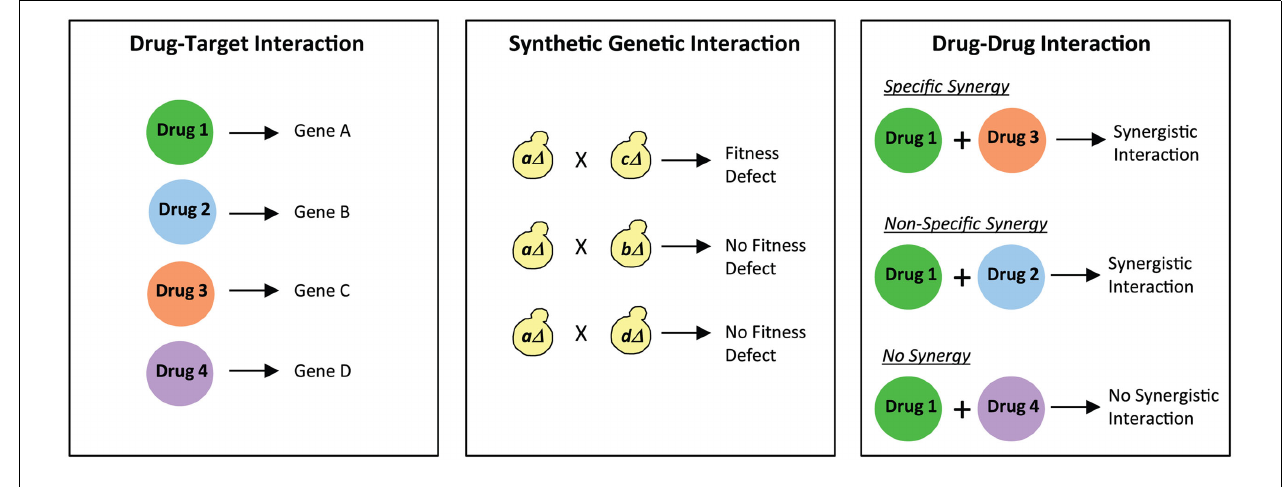
FIGURE 2 | Differentiating between specific and non-specific drug synergies. Comparing drug–target interactions with synthetic genetic interactions provides information on specific and non-specific drug synergies. For example, Drug 1 and Drug 3 exhibit specific synergy since the genes targeted by them (Gene A and Gene C) genetically interact with each